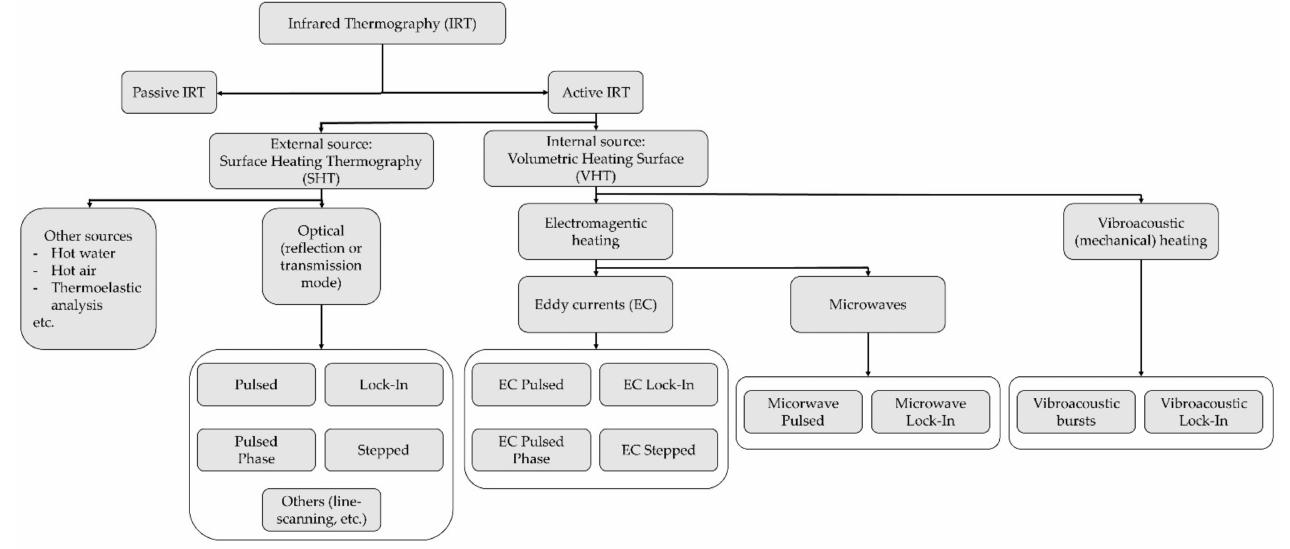
Figure 10. The main IRT techniques available as of